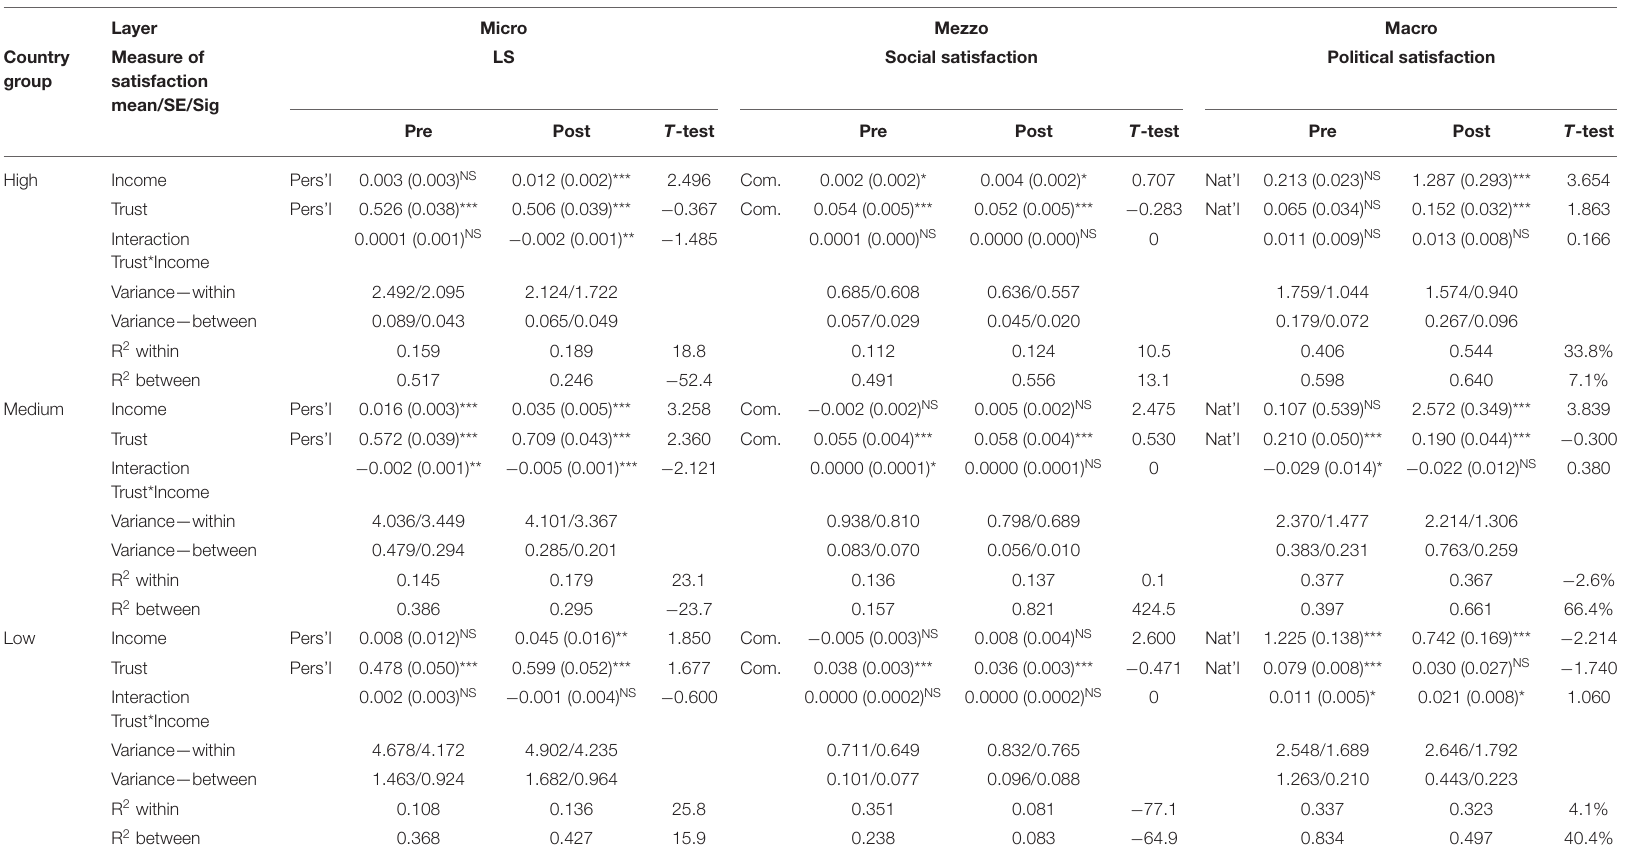
TABLE 3 | Results [fixed effects (Beta (SE) sig)] and pseudo R 2 for LS, social satisfaction, and political satisfaction as a function of their personal, community, and national income and trust parameters, respectively, before and after the financial crisis of 2008/2009.